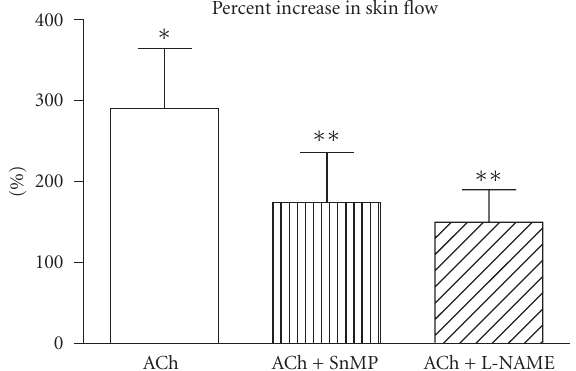
Figure 3: E ff ect of heme oxygenase inhibition with stannous meso- porphyrin IX (SnMP) (200 µ M) and nitric oxide synthase inhibition with L-NG-Nitroarginine methyl ester (L-NAME) (100 µ M) on vasodilatation induced by acethylcholine (ACh) in skin circulation evaluated by laser Doppler flowmetry. ACh, SnMP, and L-NAME were locally administered by iontophoresis. ∗ P < 0 . 05 versus baseline; ∗∗ P < 0 . 05 versus